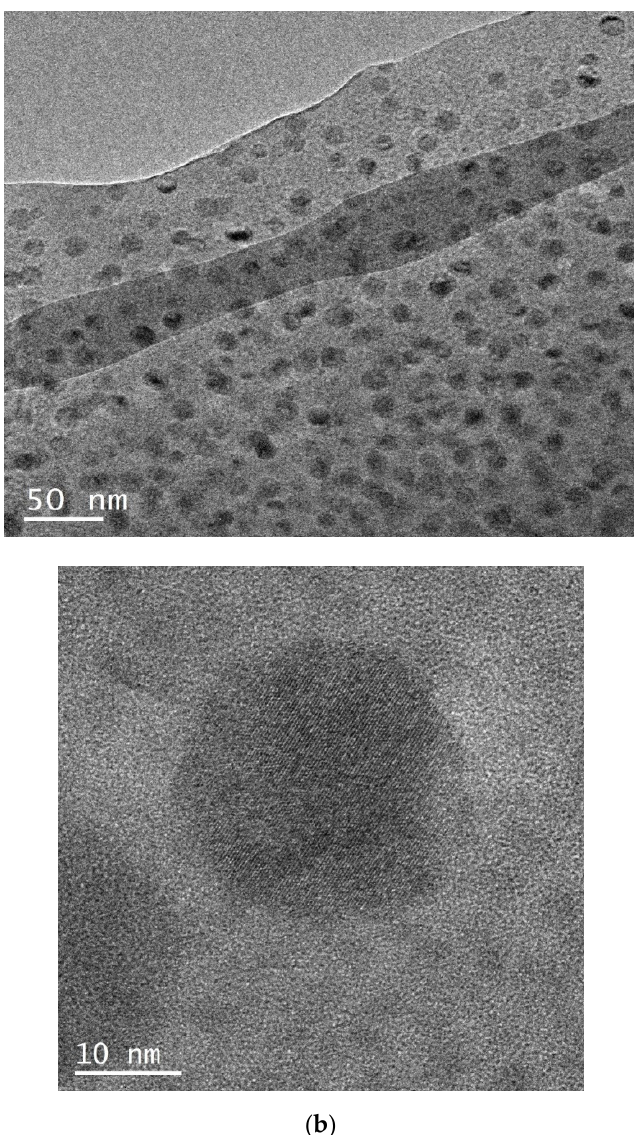
Figure 6. (a) XRD patterns for KLaF 4 : 0.5 Nd 3+ -doped transparent glass-ceramics (GCs) with different Figure 6. ( a ) XRD patterns for KLaF 4 : 0.5 Nd 3 + -doped transparent glass-ceramics (GCs) with di ff erent holding time and particle sizes, (b) TEM images of 0.5 Nd 3+ -doped transparent GCs. holding time and particle sizes, ( b ) TEM images of 0.5 Nd 3 + -doped transparent